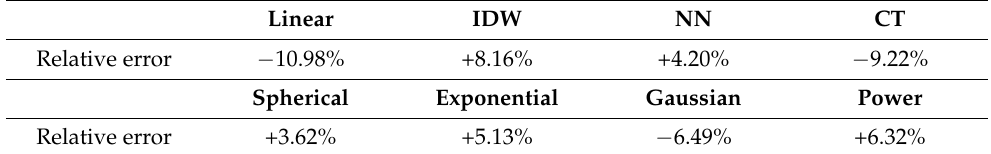
Table 4. Relative error of uranium